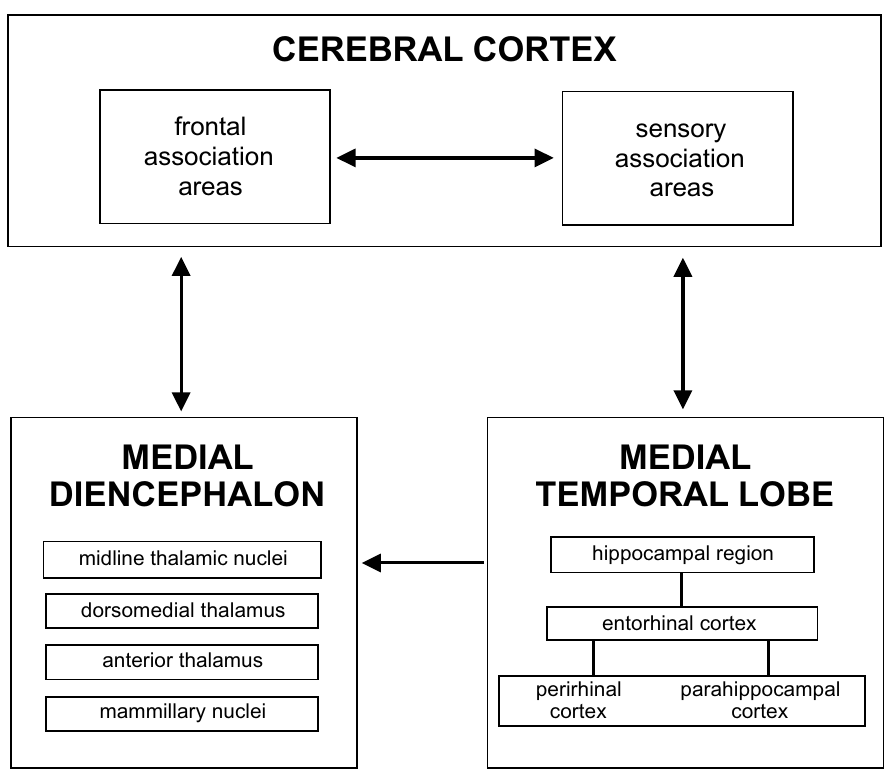
Fig. 2. Neuroanatomical regions involved in the storage of declarative memories. Figure adapted from